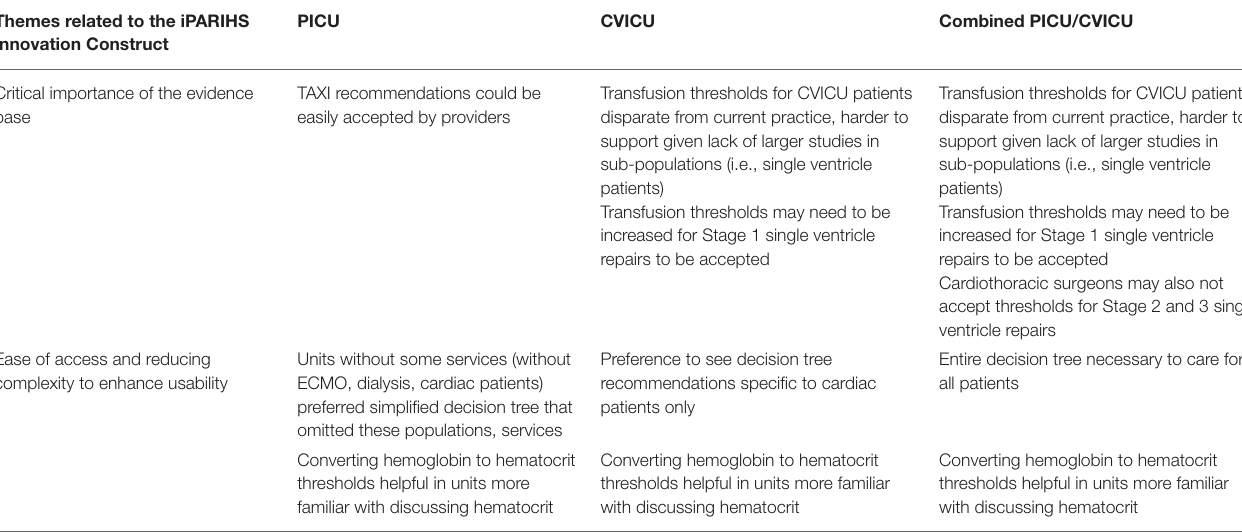
TABLE 1 | Differences in perceptions of the iPARIHS innovation construct by critical care setting. Themes related to the iPARIHS Innovation